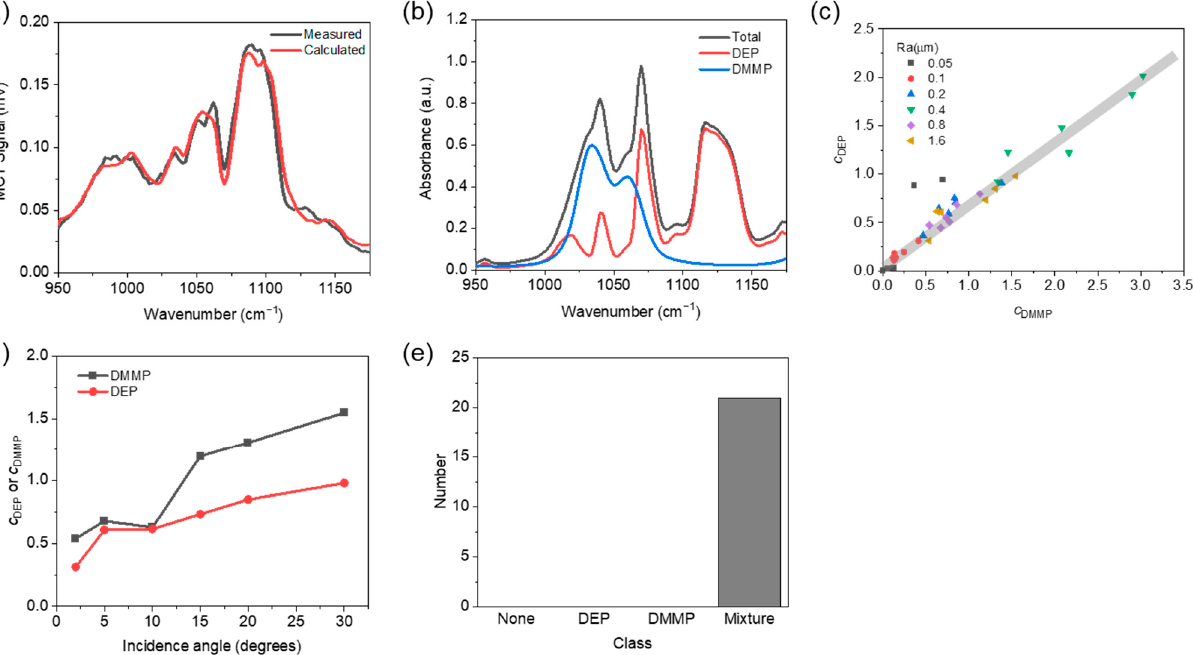
Figure 5. ( a ) Measured (black) and calculated (red) diffuse reflection spectra of DEP and DMMP 1:1 ratio mixture coated on substrate with Ra of 1.6 μ m at incidence angle of 5° for surface density of 5 g/m 2 . ( b ) Calculated absorbance spectra of DEP (red), DMMP (blue), and 1:1 ratio mixture (black) using the extracted absorbance scaling factors in ( a ). ( c ) Absorbance scaling factors of DEP ( y -axis) and DMMP ( x -axis) for a surface density of 5 g/m 2 and different surface roughness of the substrate. ( d ) Absorbance scaling factors of DEP and DMMP for substrate roughness Ra of 1.6 μ m, surface density of 5 g/m 2 according to incidence angle. ( e ) Result of classification of the mixture measurement data using the deep learning model trained for four classes of None, DEP, DMMP, and Mixture of DEP and DMMP.